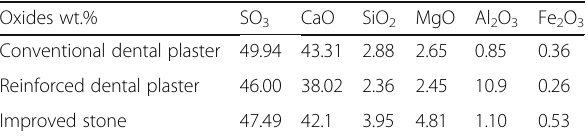
Table 1 The XRF element values (oxides wt.%) of the powders of all groups Oxides